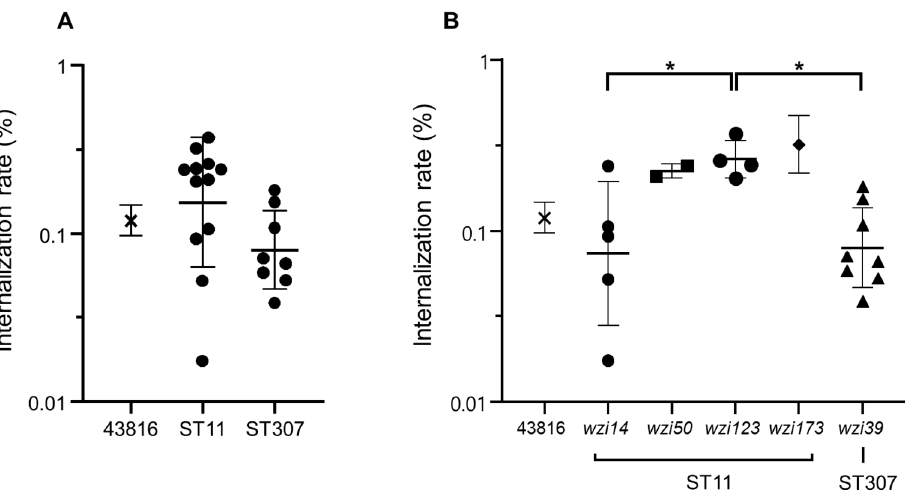
Figure 2. Results of the macrophage infection experiment. Only gentamicin ‐ susceptible isolates were included in this experiment, as gentamicin was used to eliminate extracellular bacteria. ( A ) Macrophage internalization rates in ST11 and ST307 isolates analyzed using Student’s t ‐ test. ( B ) Internalization rates were compared among the wzi allele types using ANOVA with Bonferroni’s multiple ‐ comparison test. * p < 0.05.